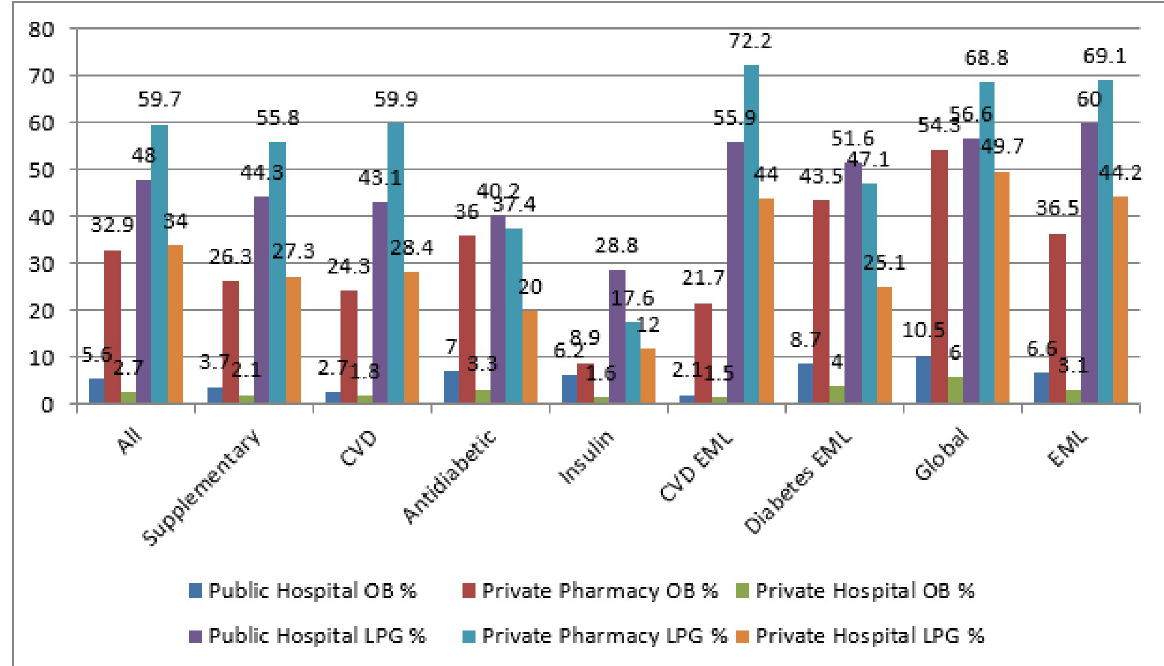
Fig 1. Availability of originator brands and generic medicines across Abuja pharmacies. CVD = Cardiovascular drugs, EML = Essential Medicine List.